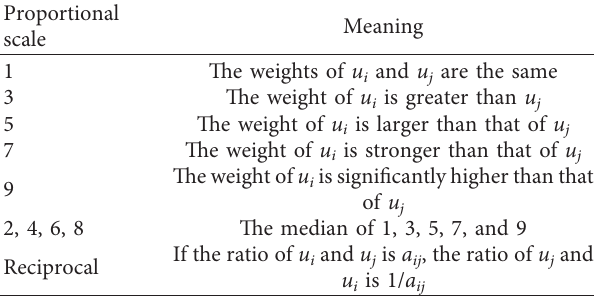
Table 3: The meaning of proportion quotient.